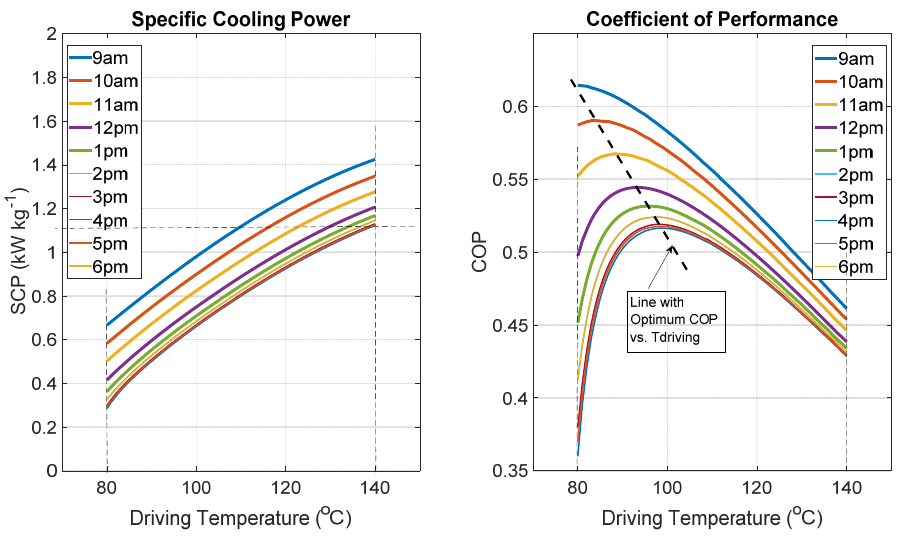
Figure 5. SCP and COP model predictions for function of driving temperature.